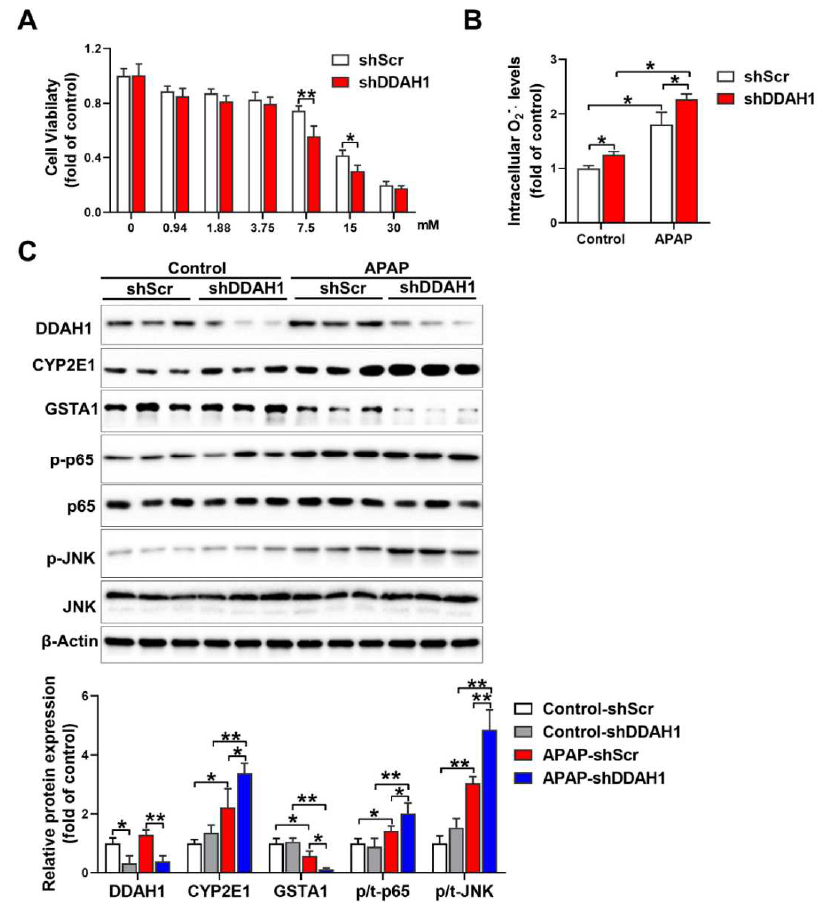
Figure 5. Effect of DDAH1 knockdown on APAP-induced cell death, oxidative stress and inflammatory pathways. ( A ) HepG2 cells stably transfected with shRNA lentiviral vectors targeting DDAH1 (shDDAH1) or a scrambled sequence (shScr) were treated with different concentrations of